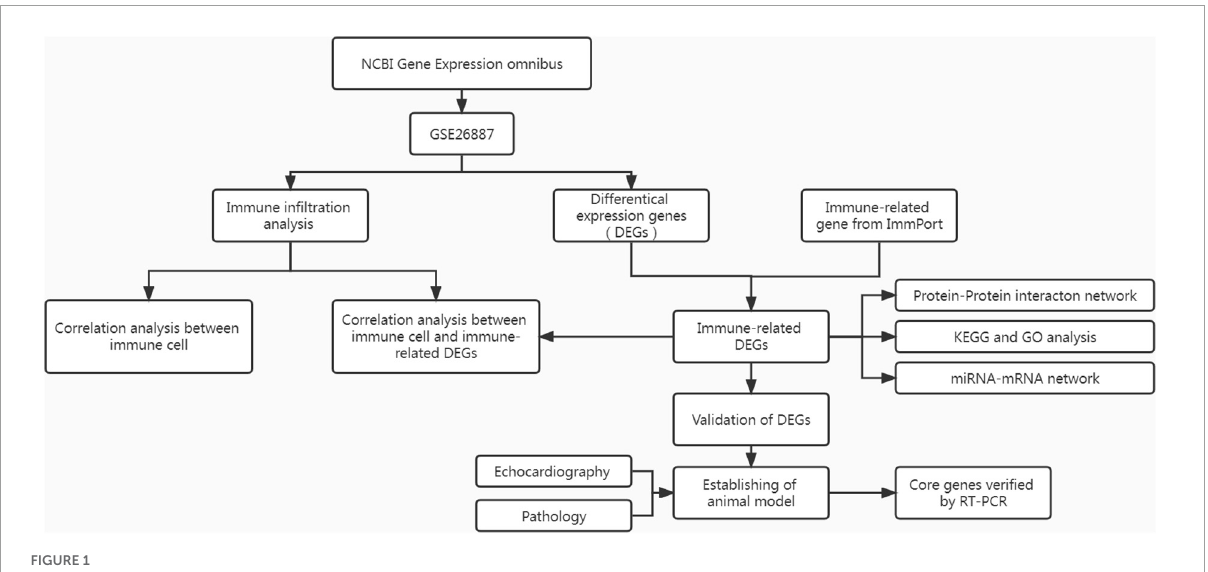
FIGURE1 The flowchart of analysis